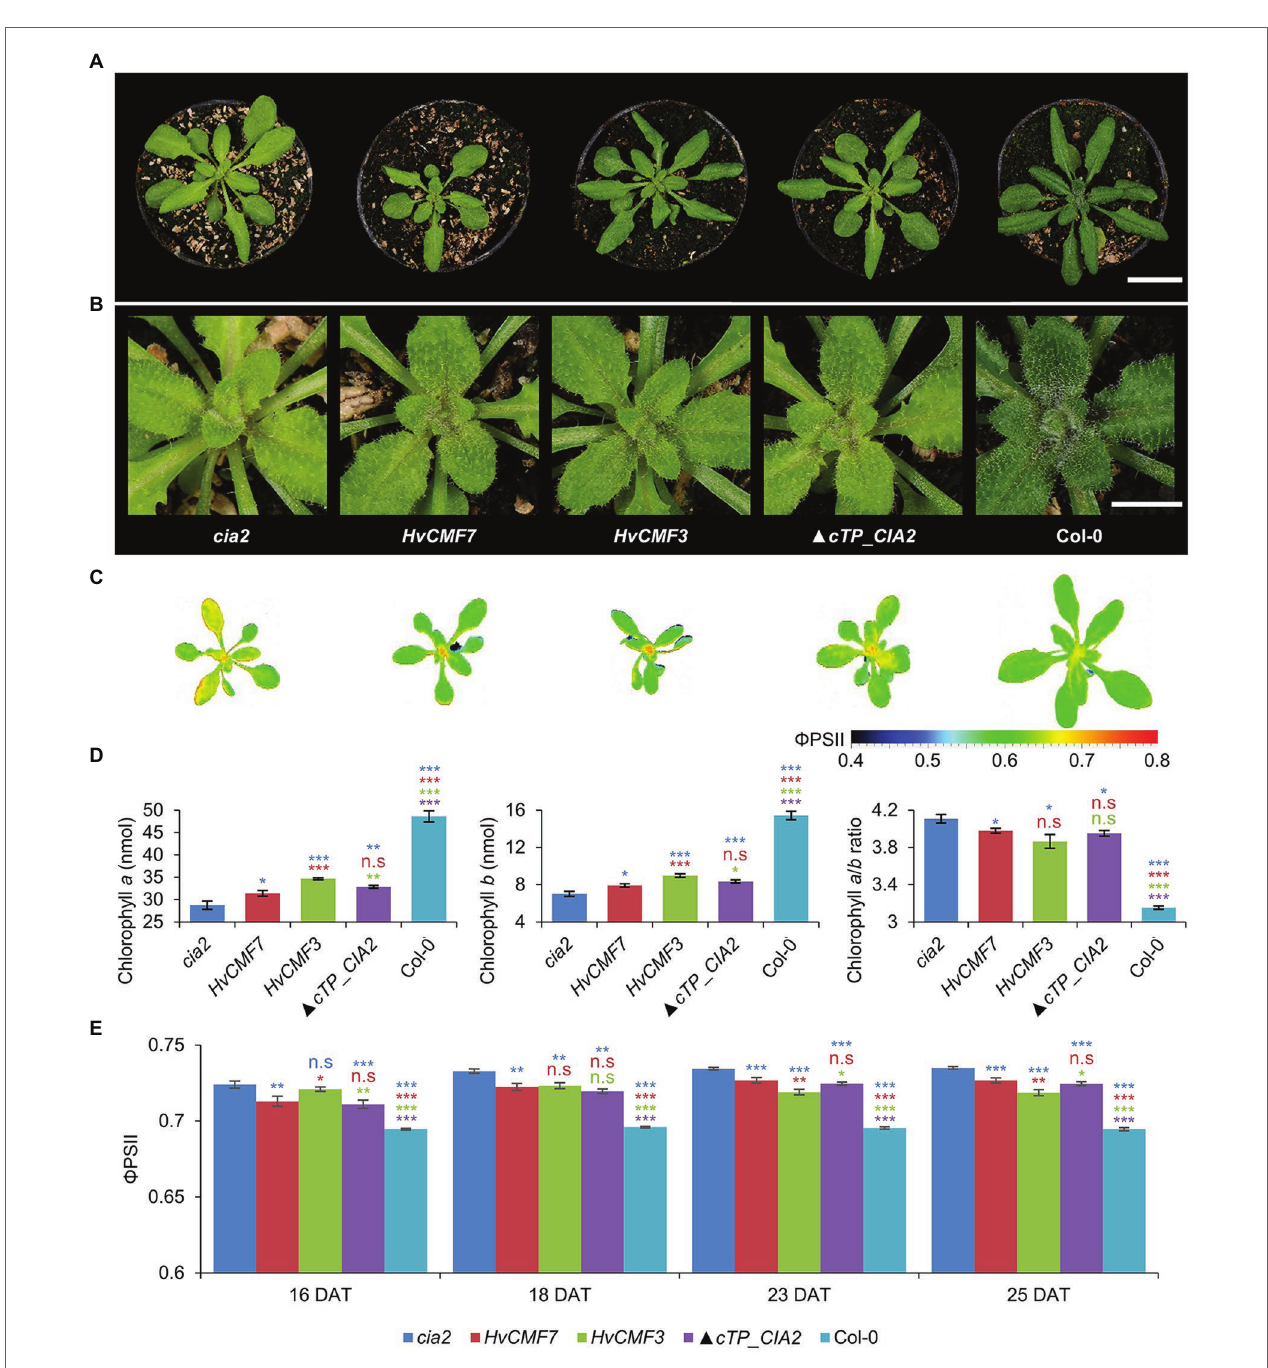
FIGURE 7 | Genetic complementation of the cia2 mutant with HvCMF3 , HvCMF7 , and ▲ cTP_CIA2 . (A) Phenotype of cia2 mutant, complementation lines, and wild type. (B) Enlargement of the central region of the respective plants in panel (A) showing phenotype of the young vegetative rosette leaves. (C) False-color images of the Φ PSII. (D) Quantification of chlorophyll contents. (E) Quantification of photosynthesis operating efficiency. Results are presented as mean ± SEM [ N ≥ 15 in panel (D) ; N ≥ 9 in panel (E) ]. Student’s t-test (Tails = 2; Type = 3) significant levels, n.s, not significant; * p < 0.05; ** p < 0.01; *** p < 0.001. From top to bottom: statistical analysis of significance was performed as compared to cia2 , HvCMF7 , HvCMF3 , and ▲ cTP_CIA2 , respectively. DAT, days after transfer to soil. Scale bar in panel (A) 2 cm. Scale bar in panel (B) 0.5